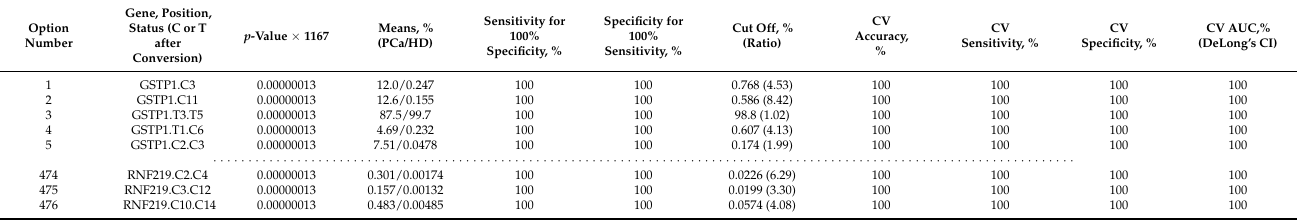
Figure 2. Correlation between the methylation of the individual cytosines of the studied locus of the GSTP1 gene in the pool of tcfDNA. Binary logarithms of the variables were used for all the plots. The diagonal cells present the density plots for the PCa (red) and HD (blue) groups for each of the variables. Each diagonal cell has its own y-axis scale, which is not labeled. “HD” and “PCa” denote the respective Pearson correlations for each of the groups. “Cor” denotes the Pearson correlation for all the groups combined; the correlations are calculated for the binary logarithms of the variables. The cells below the diagonal present scatterplots for each pair of variables. Table 5. Diagnostic value of individual cytosine or paired methylation cytosines status when PCa patients are compared with